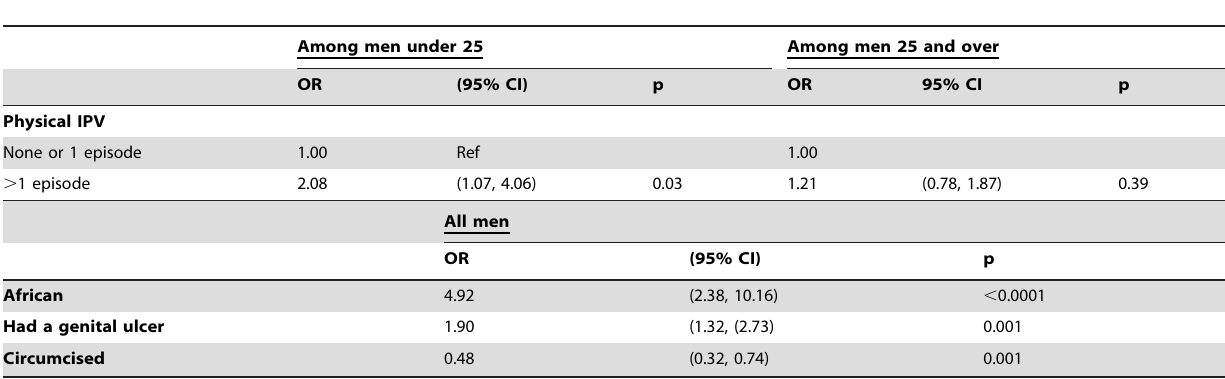
Table 4. Multivariable model showing factors associated with having HIV, including interaction between age and perpetration of physical IPV*